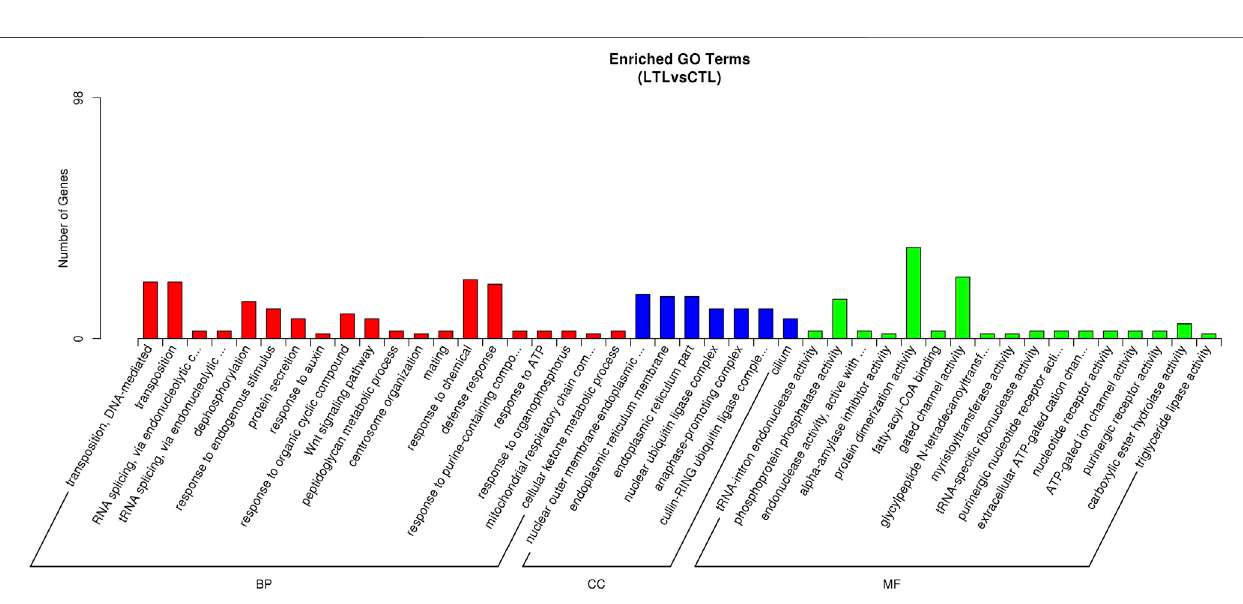
FIGURE 4 | GO annotations of miRNA target